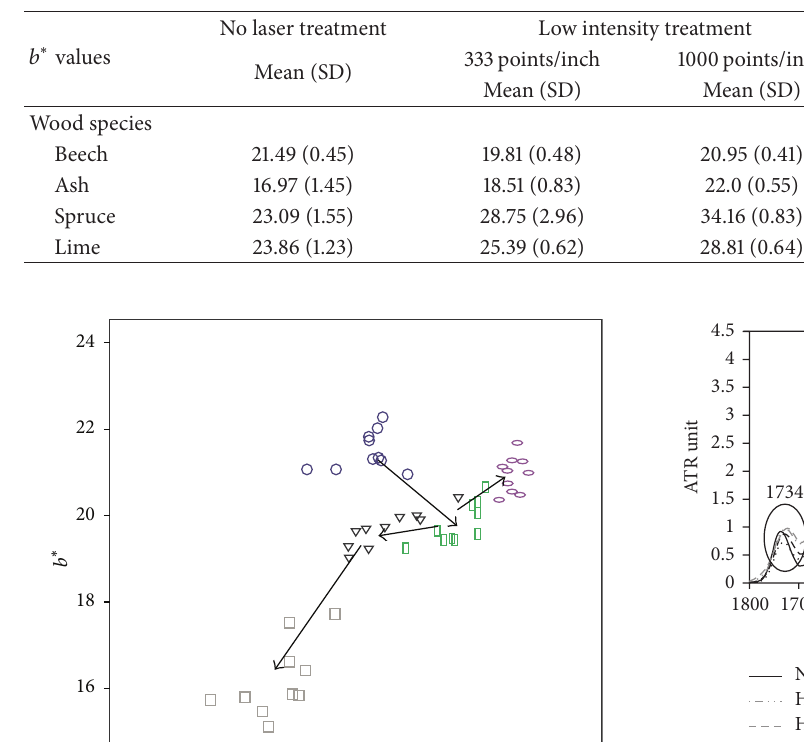
Table 3: Comparison of 𝑏 ∗ values of untreated wood surfaces with laser treated wood surfaces.